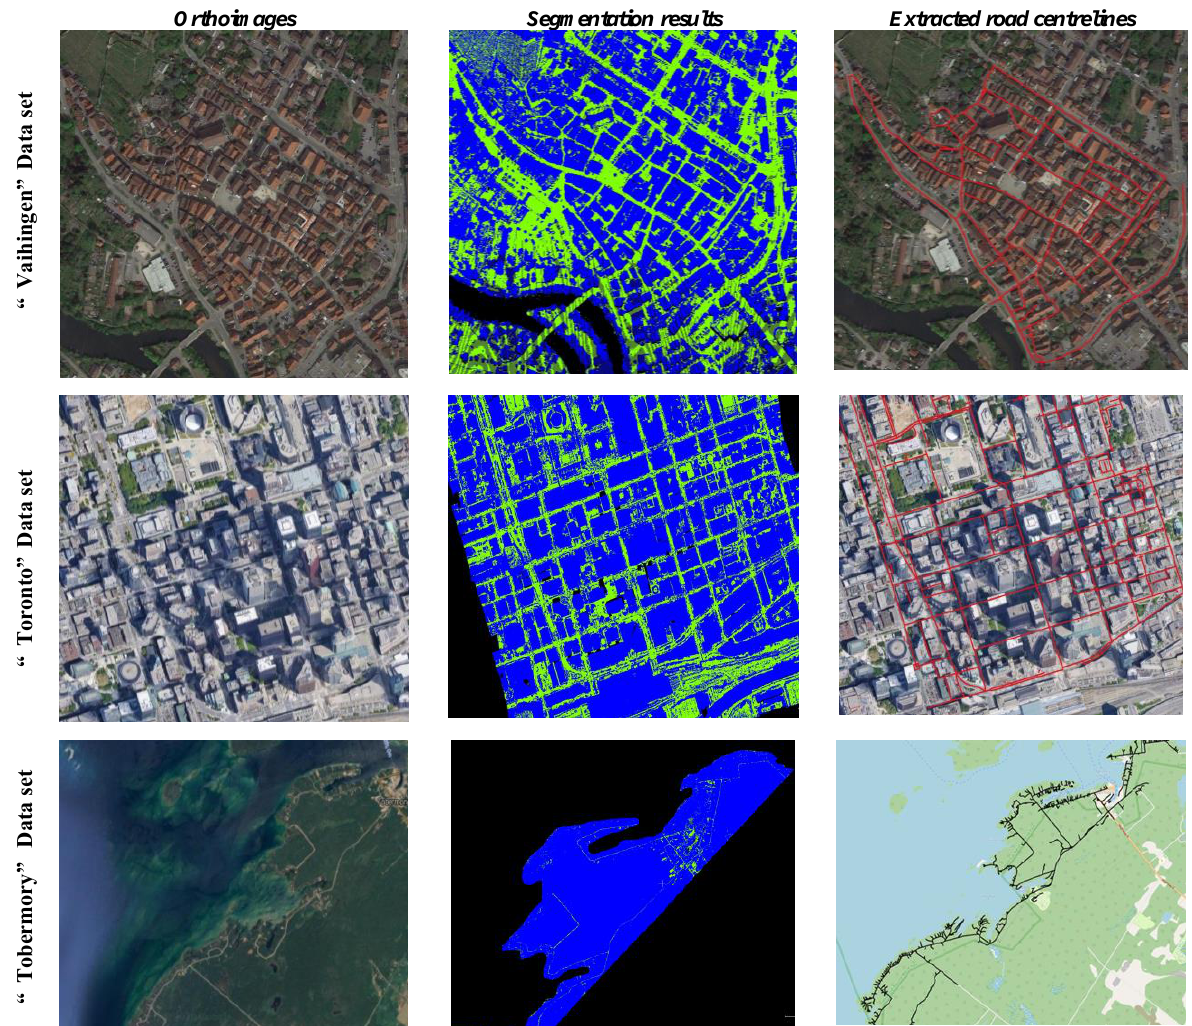
Figure 5. Results of the presented methodology applied to the “Vaihingen” (on the upper row), the “Toronto” (on the middle row), and the “Tobermory” (on the lower row). Data sets: orthoimages of interested areas are shown on the leftmost column; results of the segmentation process are shown in the central column , where ground segments are depicted in green and the remaining classes in blue; and the obtained road centrelines are displayed in the rightmost